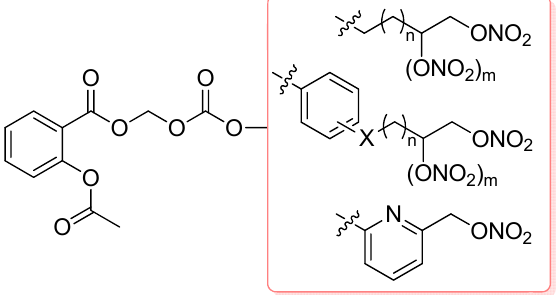
Figure 16. Nitrooxyacyloxy methyl esters of aspirin derivatives (n = 0–3; m = 0–1; X = O, CH , S, SO and SO ). 2 2